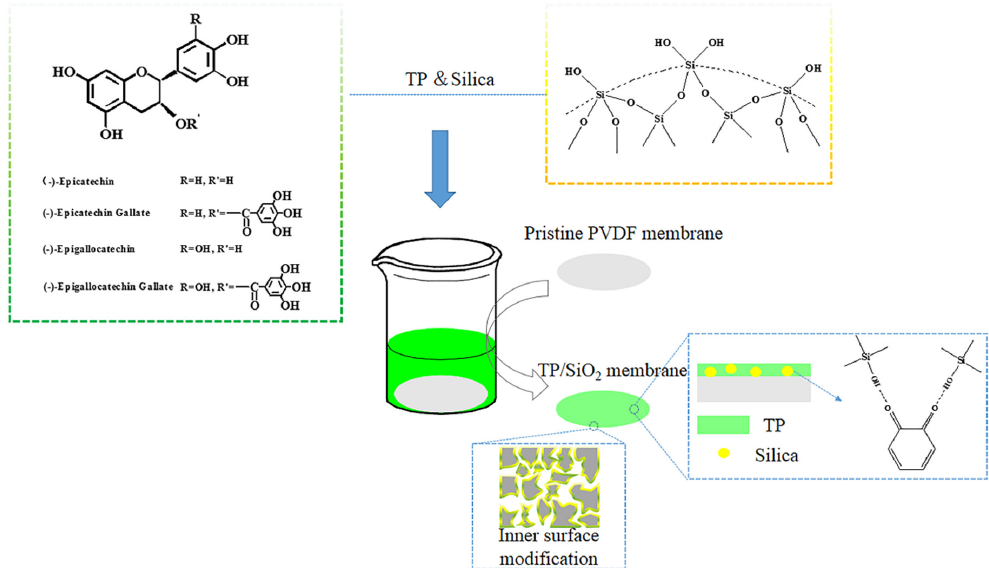
Figure 1. The coating schematic diagram of TP/SiO 2.